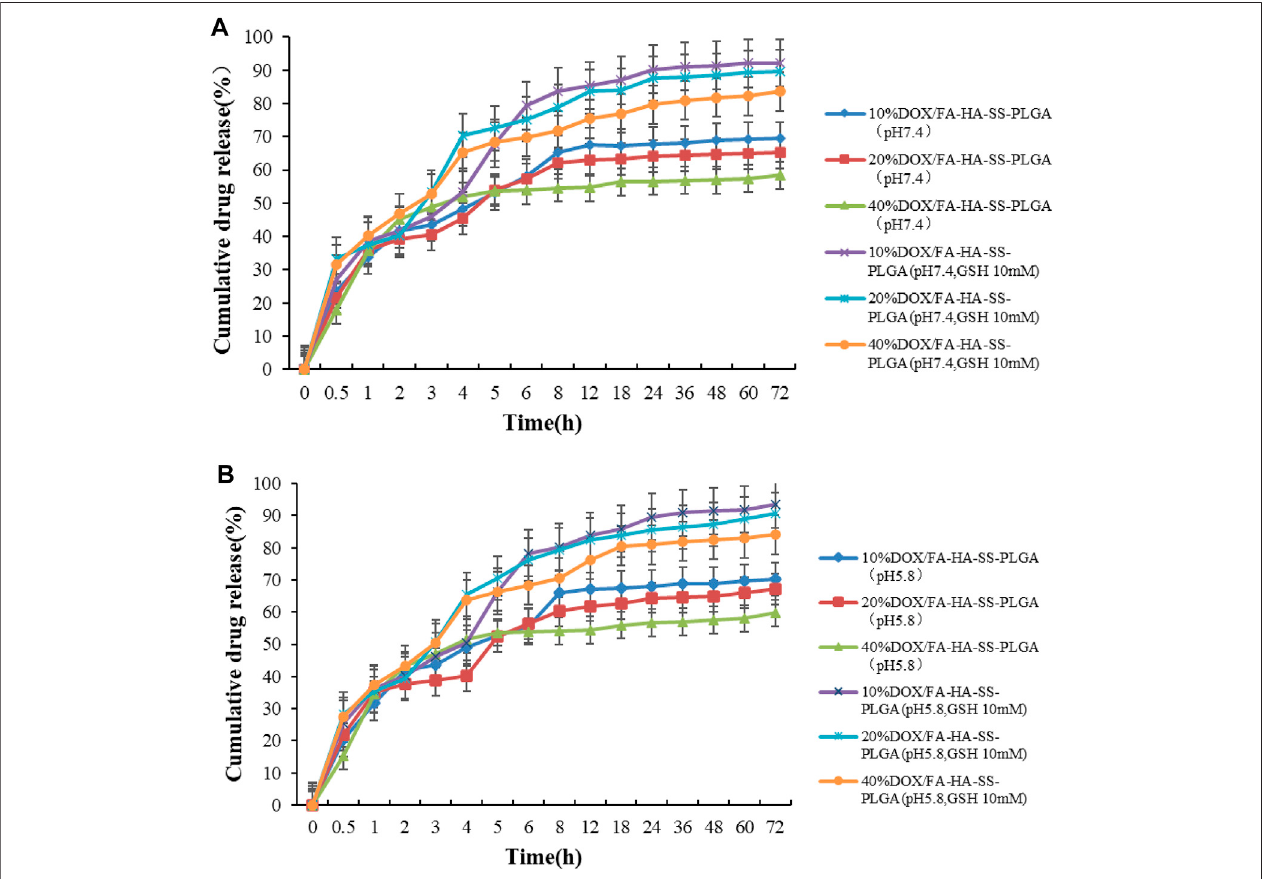
FIGURE6| Invitro releasecurveofDOX. (A) The invitro releasecurveofDOXinPBSbufferatpH7.4; (B) Invitro releasecurveofDOXinpH5.8PBSbuffer.Dataare expressed as mean ± SEM ( n = 3).